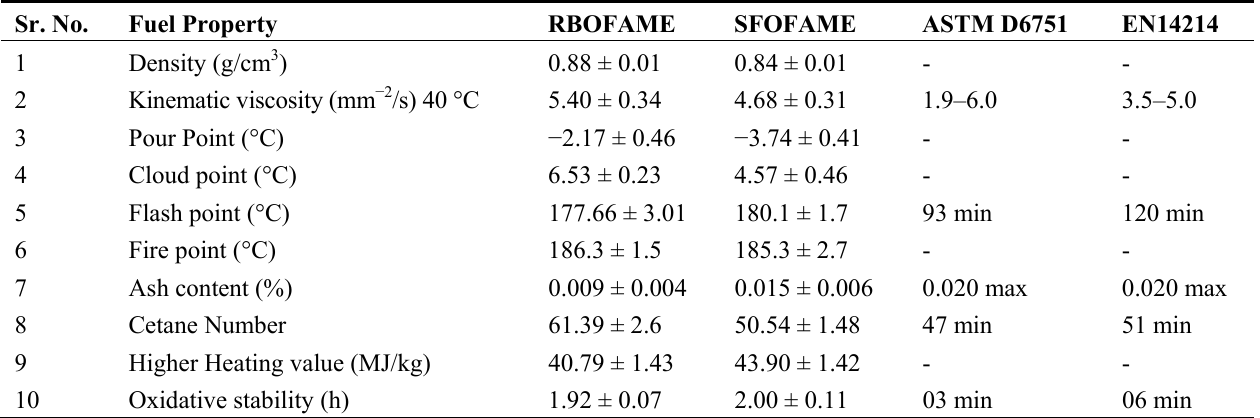
Table 9. Fuel properties of rice bran and sunflower oil based